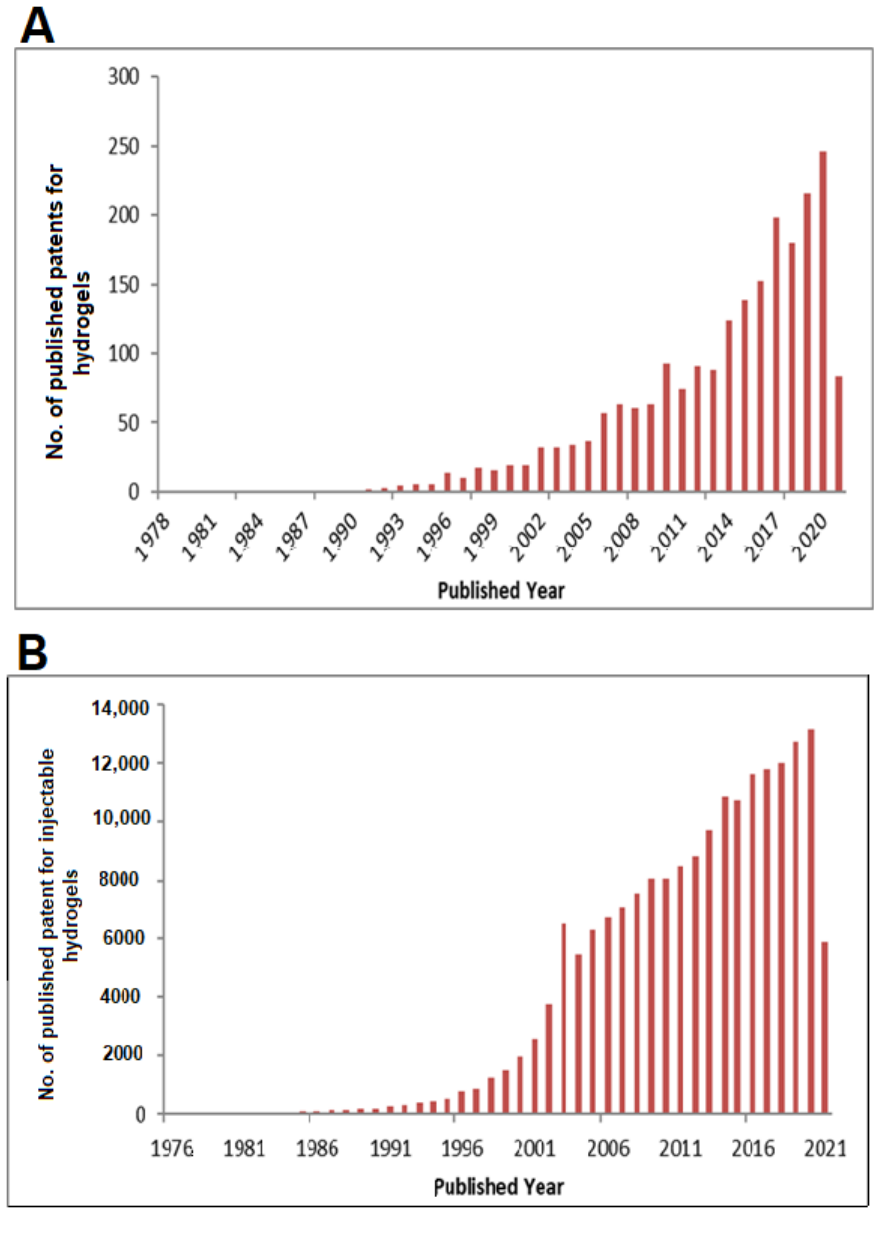
Figure 1. Histogram representing the published patents related with the hydrogels ( A ); and injectable hydrogels ( B